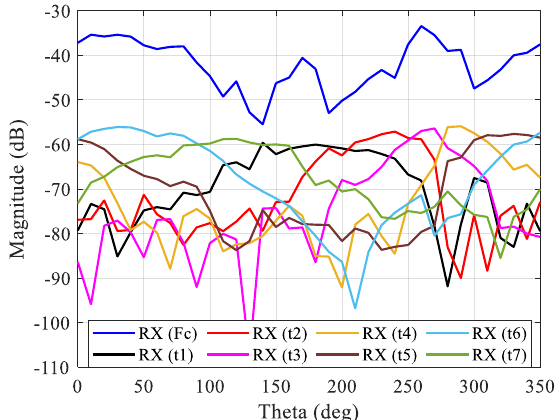
Figure 8. OTA multi-sine characterization to identify the contribution of each antenna element for case A (upper band).